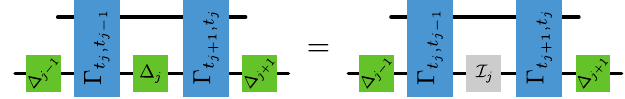
FIG. 8. NDGD system-environment dynamics. From the per- spective of a classical observer performing projective measure- ments in a fixed basis, the identity map at any time t distinguished from the completely dephasing map. Any discord (with respect to the classical basis) that is present in the system- environment state, and/or created by the system-environment CPTP maps, cannot be detected by such a classical